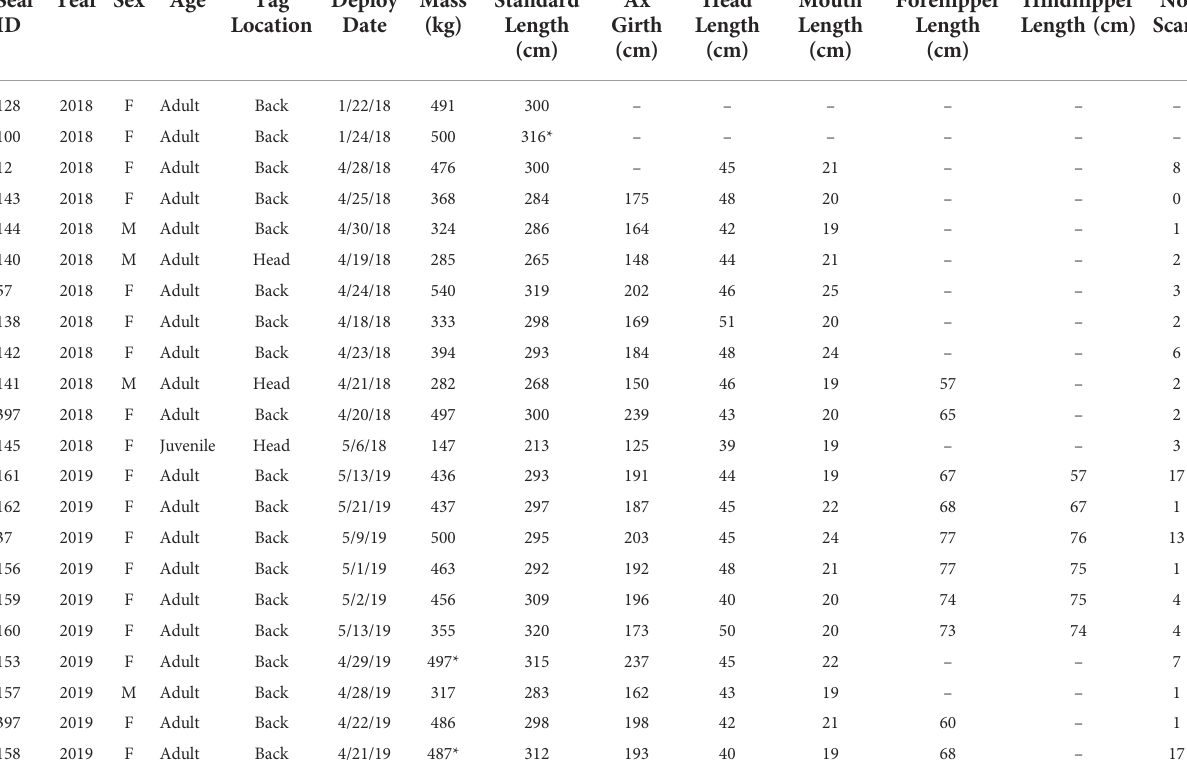
TABLE 1 Life history and morphometric data for the leopard seals in this study. Seal